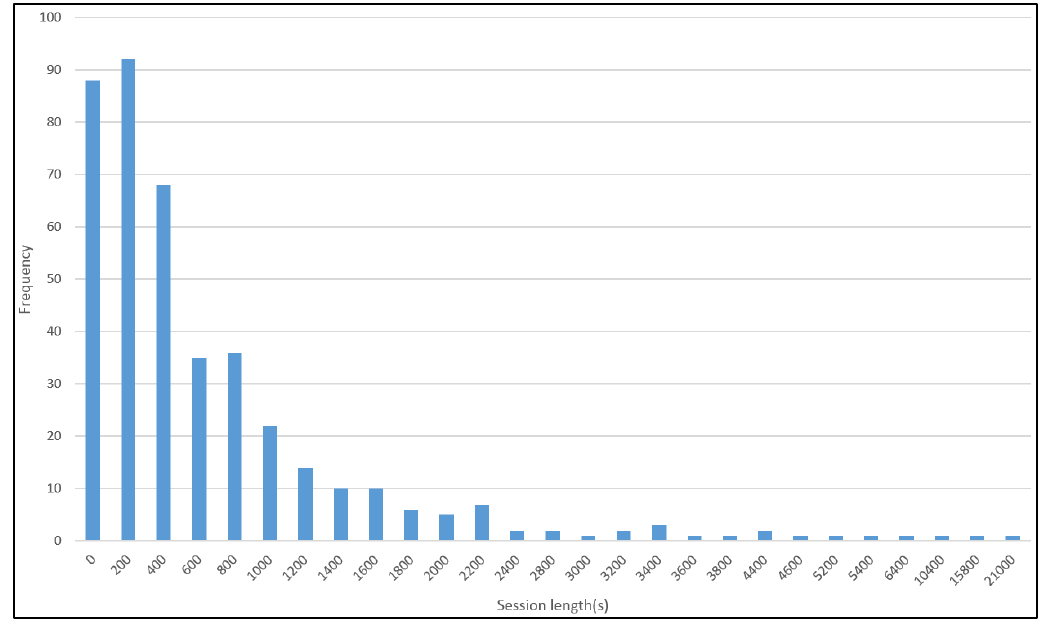
Figure 4. Example session structure results. ( a ) Session structure tree; ( b ) Query set.